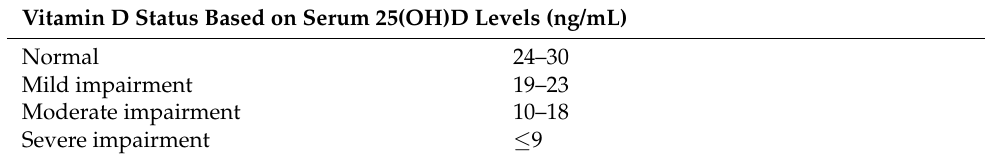
Table 4. Assessment criteria of vitamin D status based on serum 25(OH)D